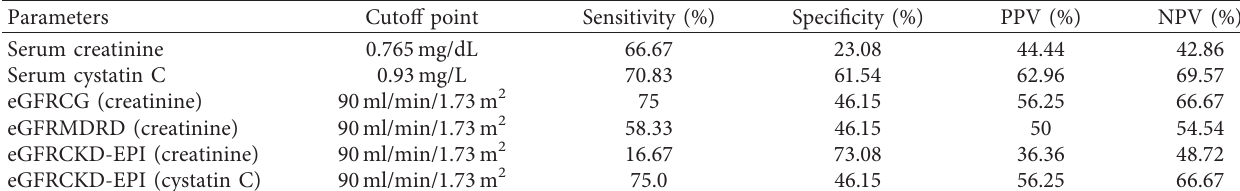
Table 4: ROC curve analysis of serum creatinine and cystatin C for diagnostic accuracy.